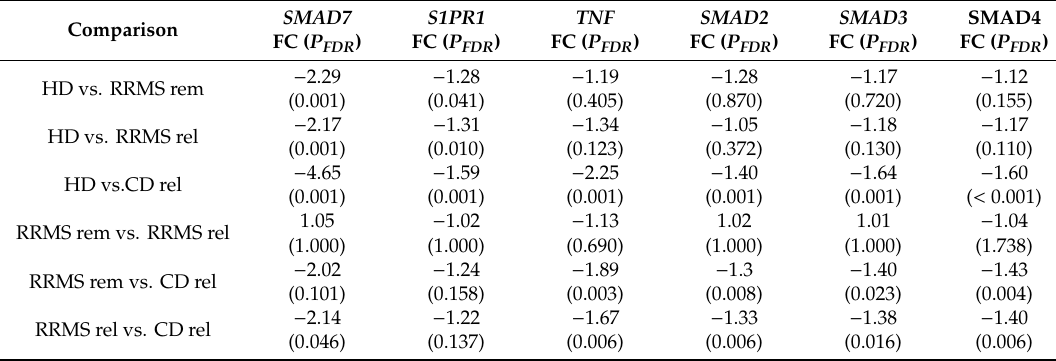
Table 3. Statistical analysis and ratios of di ff erential gene expression between